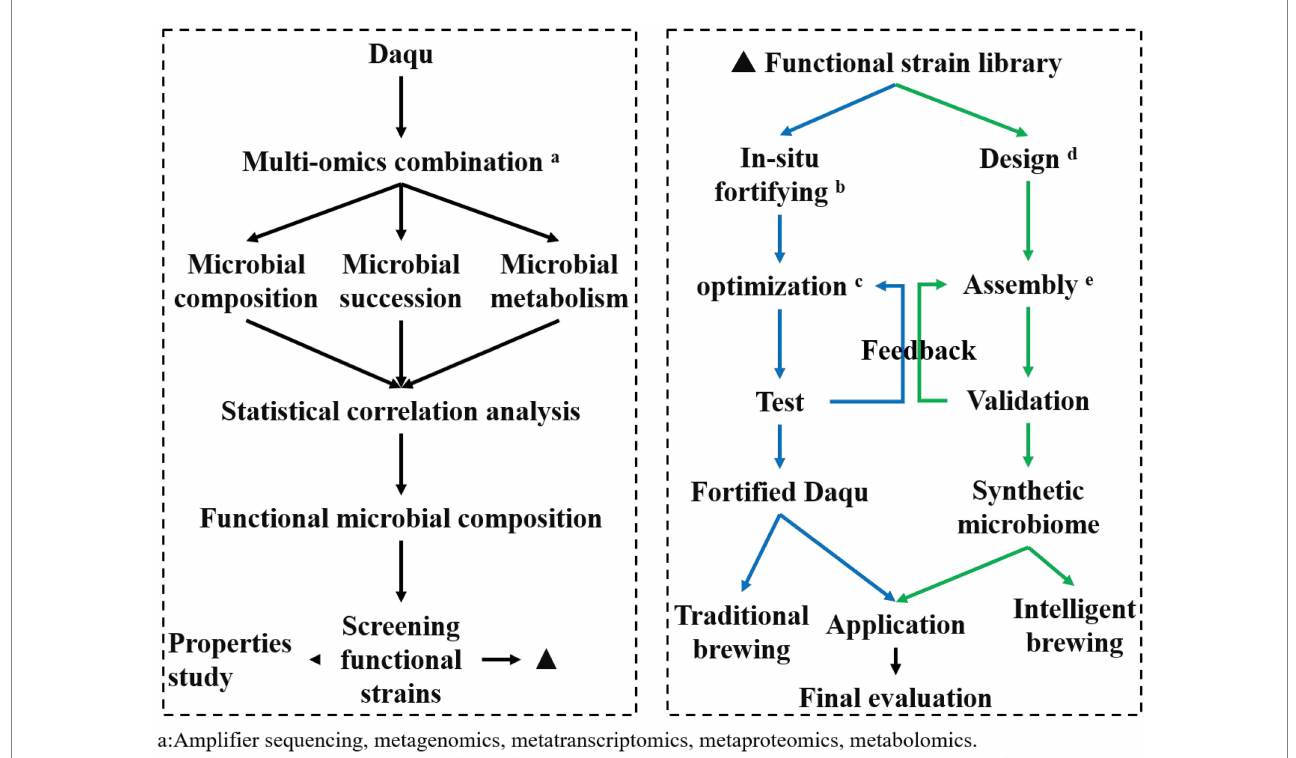
FIGURE 2 Application strategy of Baijiu-making functional